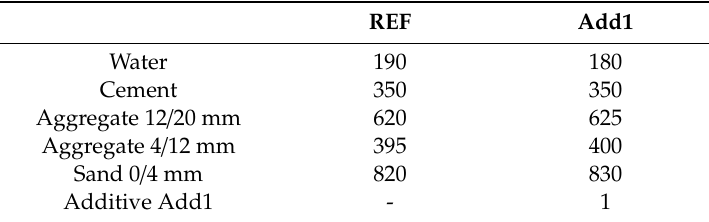
Table 2. Nominal composition of the fabricated concretes (kg / m 3